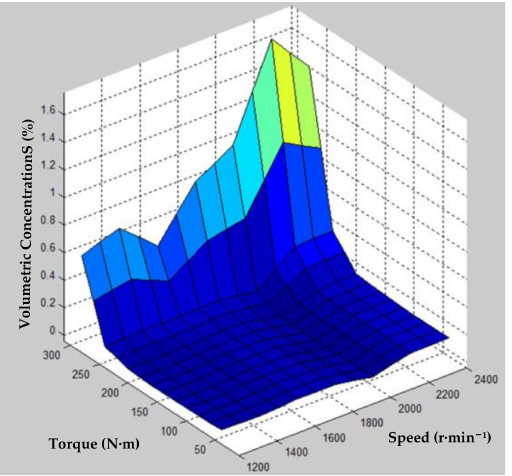
Figure 6. Three dimensional map of the CO volume concentration.